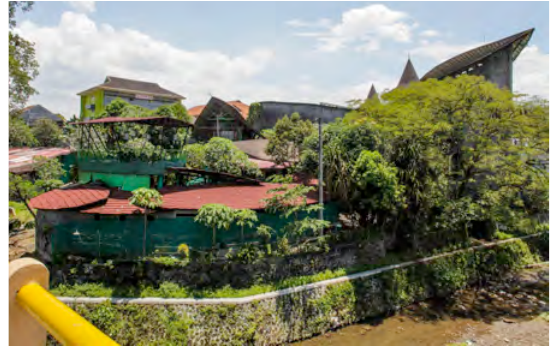
Figure 1: The Affandi Museum (U. Herbig,